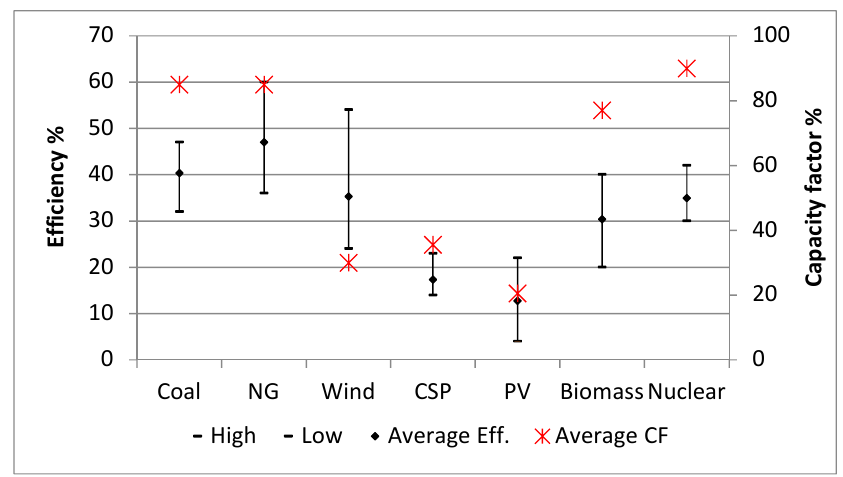
Figure 1. Efficiency of electricity generation and capacity factor of technologies under assessment [15,40–46].